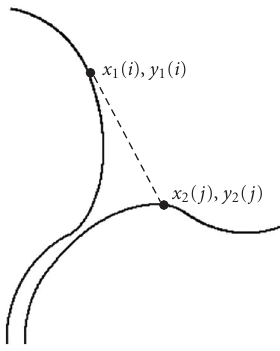
Figure 4: Rotor-rotor clearance